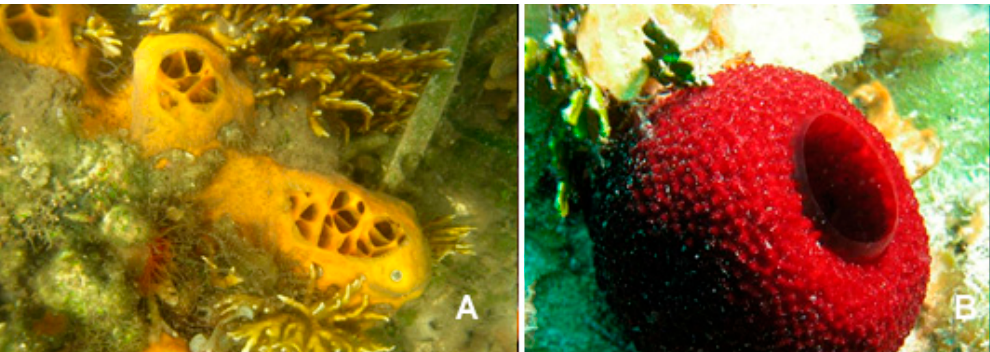
Figure 12. Two examples of species of the genus Mycale . ( A ) Mycale laevis , (Carter, 1882); CC0 1.0 (Public domain) https://serv.biokic.asu.edu/imglib/stri/misc/201605/13568_1464650224_web.jpg. ( B ) Mycale laxissima (Duchassaing and Michelotti, 1864); https://spongeguide.uncw.edu/imageinfo.php?img=319.